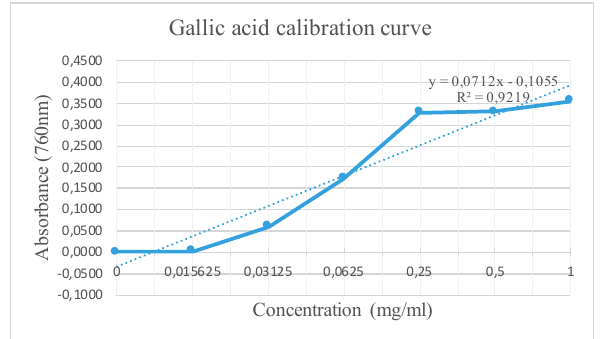
Figure 1. Gallic acid calibration curve for determination of Total phenolic content for hexane and methanol extracts.